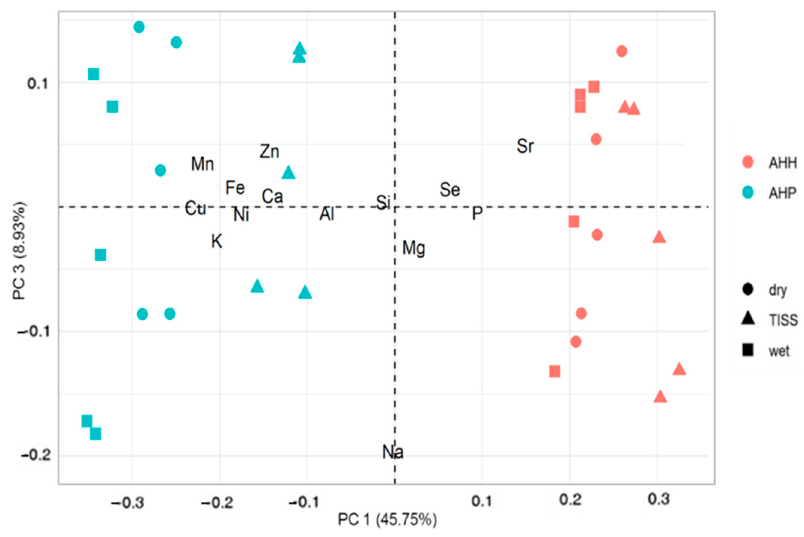
Figure 3. PCA of the whole ICP-OES data matrix: biplot of PC 3 vs. PC 1. Light-blue symbols for AHP samples, orange symbols for AHH samples, squares for mineralized floured samples, circles for ashes, triangle for TISS fractions.